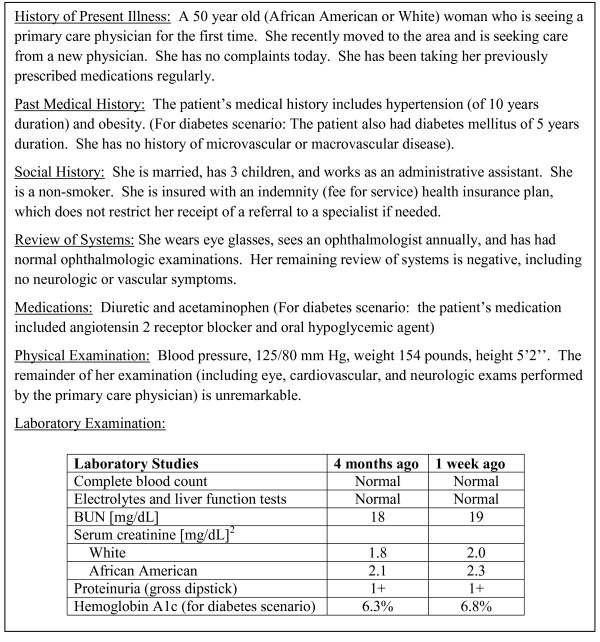
Hypothetical case scenario. We provided primary care physicians with one of four randomly assigned hypothetical scenarios, which varied on patient race (African American or White) and the presence or absence of diabetes. * Complete blood count includes hemoglobin, hematocrit, platelet count, and white blood cell count. † For the "4 month ago values", the estimated glomerular filtration rate (eGFR) for the White and African American patient was 32 mL/min/1.73m2 and for the "1 week ago" values the eGFR was 28 and 29 mL/min/1.73m2, respectively (using the 4-variable Modification of Diet in Renal Disease Study equation)[20].